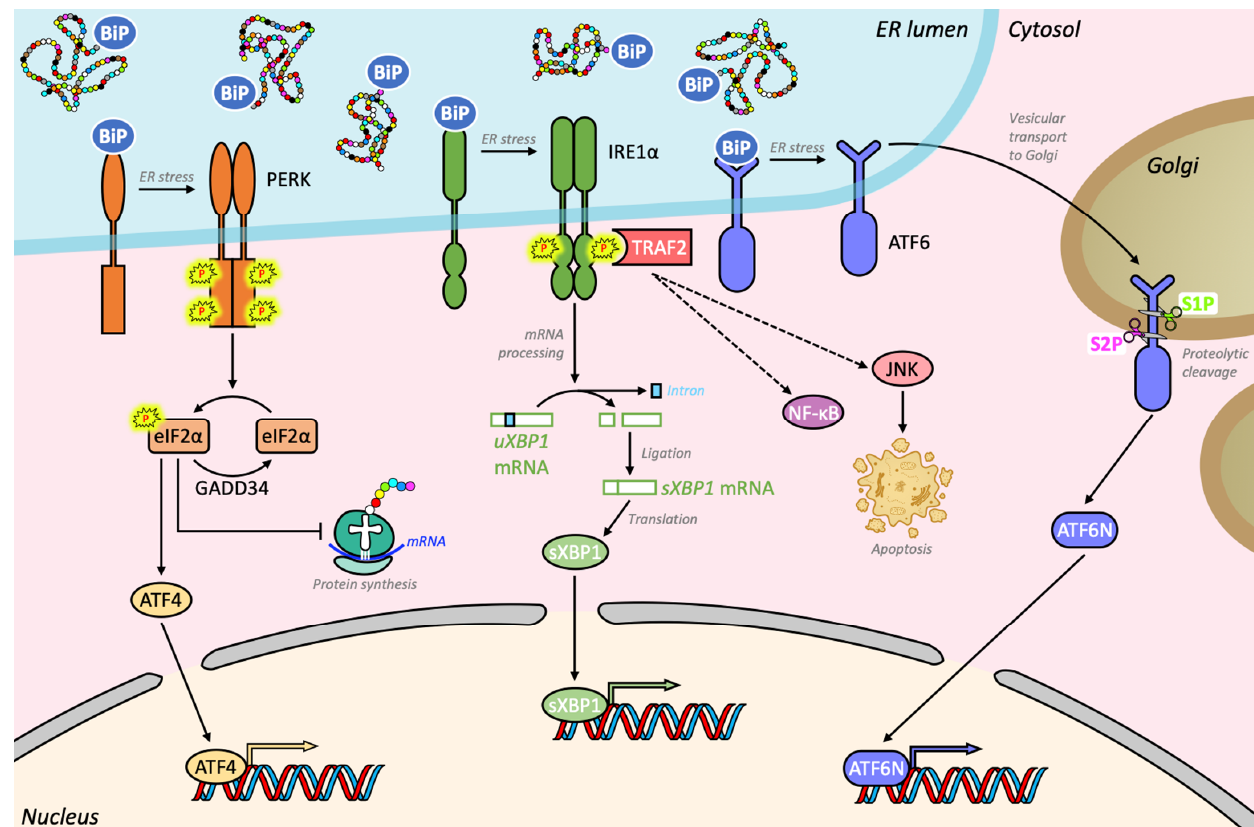
Figure 2. Schematic representation of the unfolded protein response (UPR) pathways in skeletal muscle. The three transmembrane proteins, PERK, IRE1α, and ATF6, are inactive when bound by BiP, also called GRP78. Due to the accumulation of misfolded proteins, GRP78/BiP disassociate from these proteins and preferentially binds to these proteins in the lumen of the ER. No longer inactivated by GRP78/BiP, PERK auto-phosphorylates causing phosphorylation of the translation initiation factor eIF2α and translation of the mRNA encoding ATF4, a potent transcription factor, which in turn can activate its transcriptional targets. One of these targets encodes GADD34, a phosphatase involved in the negative feedback control of this pathway, which allows a return to a physiological translational state. Another ER transmembrane sensor, IRE1α, is also activated by autophosphorylation during ER stress. When active, IRE1α catalyzes the unconventional splicing of a 26-base intron from XBP1 mRNA through its endoribonuclease activity, which generates the highly active transcription factor transcription factor sXBP1, as well as phosphorylates c-Jun N-terminal kinase (JNK). Lastly, once disassociated from GRP78/BiP, the membrane-bound ATF6 is released and traffics from the ER to the Golgi apparatus where it undergoes two sequential proteolytic cleavages, mediated by the site-1 and site-2 proteases (S1P and S2P). The cleaved cytosolic N-terminal fragment of ATF6 (ATF6N) translocates to the nucleus where it acts in combination with sXBP1 and ATF4 to alleviate ER stress by regulating gene expression and protein synthesis.